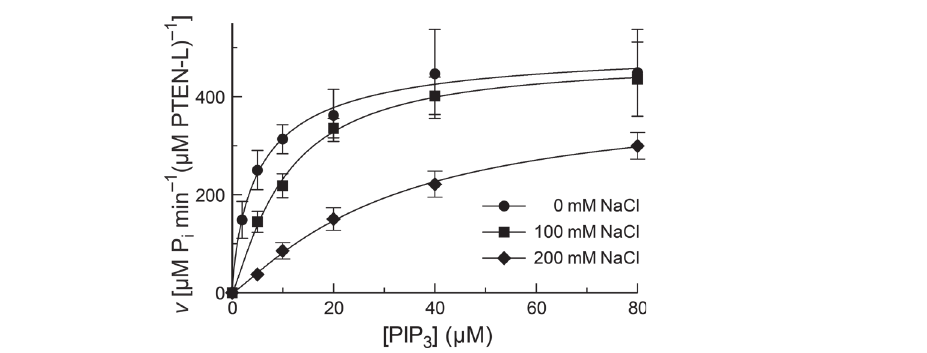
Figure 6. Turnover of PIP 3 by PTEN-L in solutions of various salt concentrations. Reactions were performed in 50 mM Tris – HCl buffer, pH 7.6, containing NaCl (0, 100, or 200 mM), EDTA (2.0 mM), MESG (0.20 mM), and DTBA (40 mM), and were initiated with the addition of PTEN-L to 20 nM. Values are for maximum reaction velocity ( ± SE) at < 10% turnover of substrate in reactions performed in triplicate or more. The resulting kinetic parameters are listed in Table